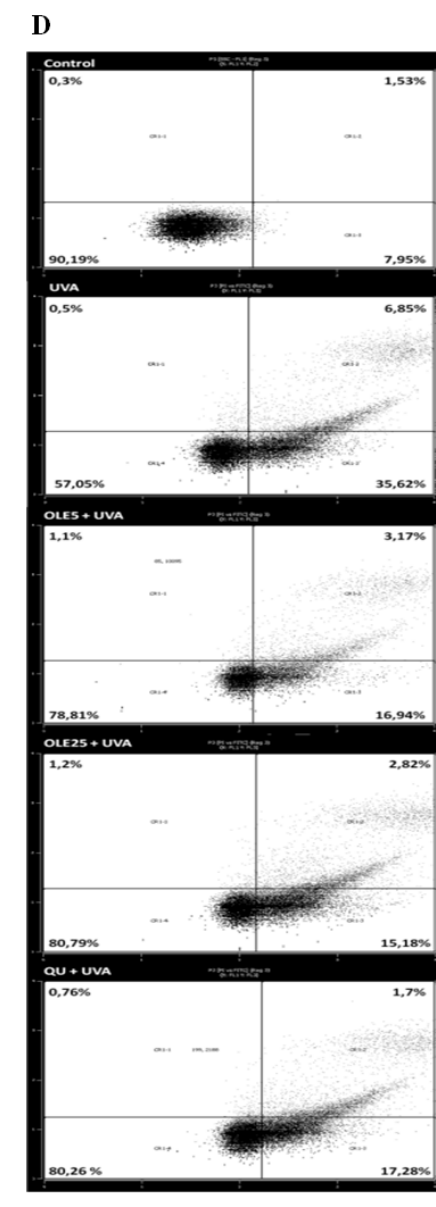
Figure 2. The effects of different concentrations of OLE on the viability of human skin fibroblasts. Cells cultured (24 h) in the presence of OLE (2.5 –25 μg/mL), vehicle (0), or the reference antioxidants AA and QU (25 μg/mL) not irradiated ( A ) or exposed to UVA-irradiation (8 J/cm 2 ) ( B ) were cultured for an additional 24 h, and then subjected to CCK-8 assay. The cytotoxicity of OLE and fibroblast survival were expressed as a percentage of control, where the absorbance of untreated and of corresponding non-irradiated cells were taken as 100%, respectively. The post-radiation viability of fibroblasts evaluated by the Annexin V-FITC/PI staining (flow cytometry) assay ( C ). A representative dot-plot histogram is shown ( D ), cell populations in II, I and III/IV quadrants represent alive, undergoing necrosis and undergoing apoptosis Hs68 cells, respectively. The figure shows mean results from 3–6 independent experiments. Error bars denote ±SD. * p < 0.05; ** p < 0.01; *** p < 0.001 compared to control (0).